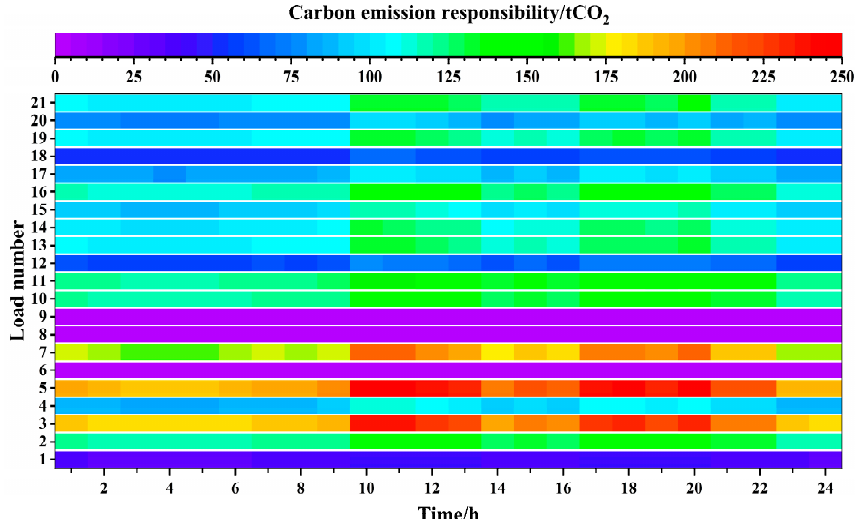
Figure 6. Carbon-emission responsibilities of 21 loads allocated by Aumann–Shapley method.